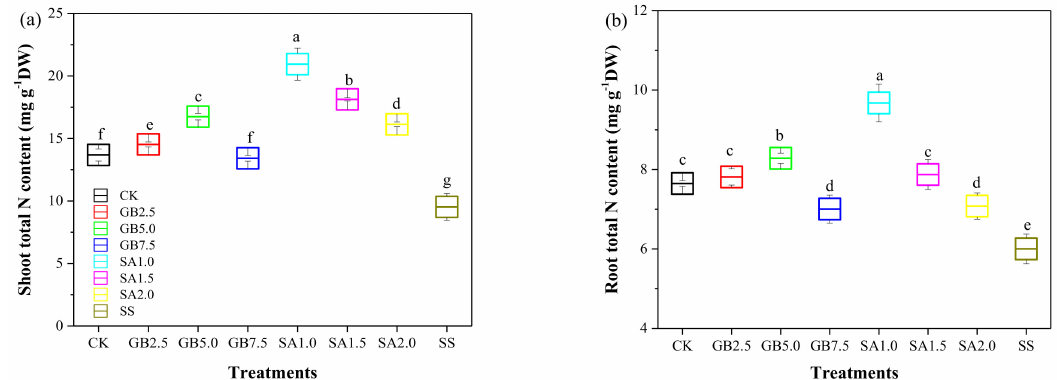
Figure 3. Effect of exogenous glycine betaine (GB) and salicylic acid (SA) on ( a ) shoot total nitrogen (N) content and ( b ) root total N content under the 150 mM NaCl condition. Treatments: CK, control; GB2.5, 2.5 mM GB; GB5.0, 5.0 mM GB; GB7.5, 7.5 mM GB; SA1.0, 1.0 mM SA; SA1.5, 1.5 mM SA; SA2.0, 2.0 mM SA; SS, salt stress (150 mM) without supplementation. Values are means ± standard deviation (n = 3). Different letters represent significant differences between the experimental treatments at p <